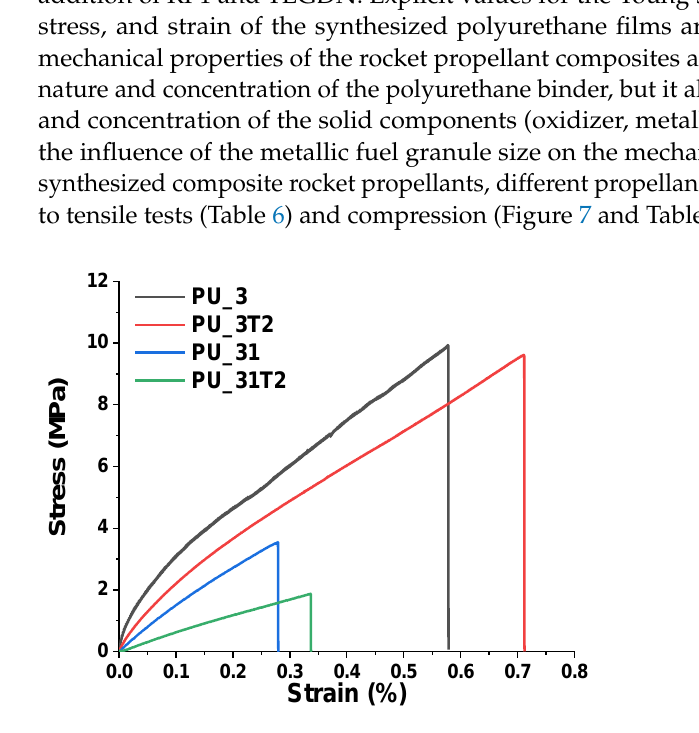
Figure 6. Tensile stress – strain plots of polyurethane films. Table 5. Tensile characteristics of polyurethane films.